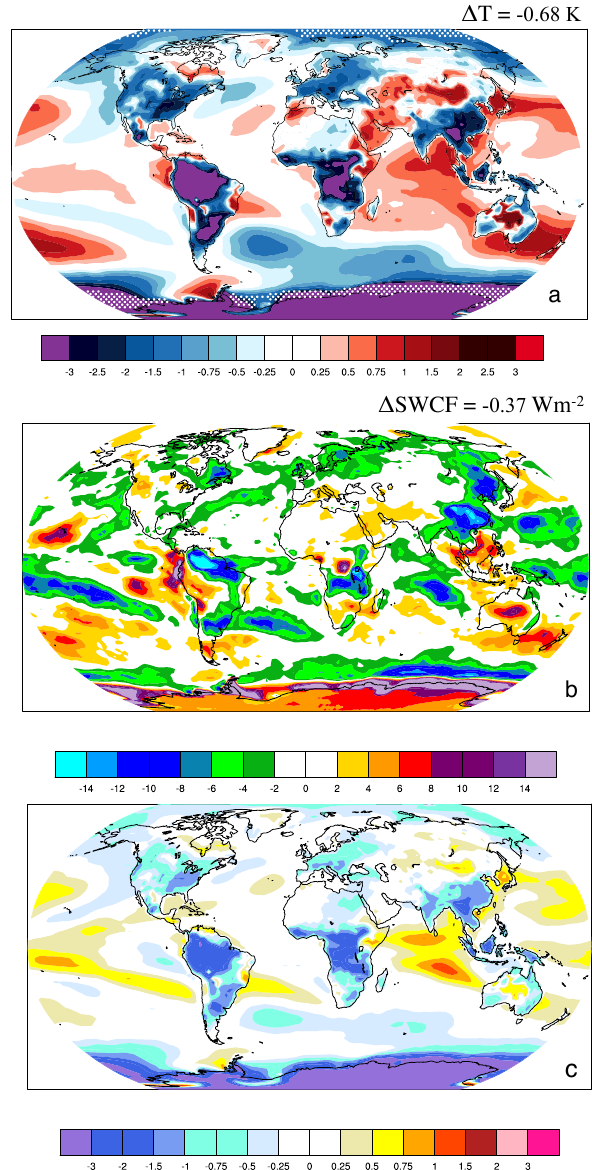
Fig. 7. Glaciated minus unglaciated modern simulation at 1120ppm CO 2 (( α + oro) experiment highlighted with a light grey shade) in Figure 6. Glaciated minus unglaciated anomalies from experiment 2 minus 7 (highlighted in blue) Fig. 6. Glaciated minus unglaciated Eocene simulation at 1120ppm Table 1. (a) Annually averaged anomalies for surface temperature in Table 1. (a) Annually averaged anomalies for surface temperature anomalies (K) as the contour CO 2 (( α +oro) experiment highlighted with a dark grey shade) in Figure 5. Glaciated minus unglaciated anomalies from experiment 10 minus 15 (highlighted in red) in Table anomalies (K) as the contour and the sea ice anomalies stippled in and the sea ice anomalies stippled in white, (b) shortwave cloud forcing (SWCF) in Wm -2 , and (c) Table 1. (a) Annually averaged anomalies for surface temperature 1. (a) Annually averaged anomalies for surface temperature (K) as the contour and the sea ice anomalies white, (b) short-wave cloud forcing (SWCF) in Wm − 2 , and (c) nor- normalized g a (greenhouse effect without clouds) in % for the 1120 ppm CO 2 Modern glaciated (K) as the contour and the sea ice anomalies stippled in white, stippled in white, shortwave cloud forcing (SWCF) in Wm -2 (b), and (c) normalized g a (greenhouse effect malized g a (greenhouse effect without clouds) in %. The calculation versus unglaciated simulation. The calculation for g a is described in results section 3.2.2, Eq. (14) . (b) short-wave cloud forcing (SWCF) in Wm − 2 , and (c) normal- without clouds) anomaly in % for the 1120 ppm CO 2 Eocene glaciated versus unglaciated simulation. The for g a is described in results Sect. 3.2.2, Eq. ized g a (greenhouse effect without clouds) anomaly in %. The cal- calculation for g a is described in results section 3.2.2, Eq. (14) . culation for g a is described in results Sect. 3.2.2, Eq. (11).